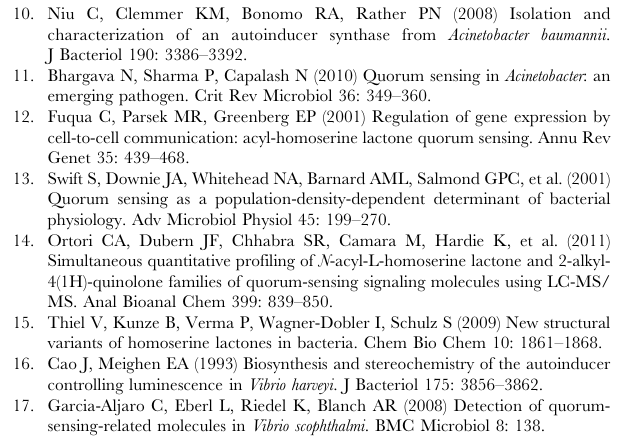
Figure S1 Conformations used for the analysis of the Mosher esters of 3b. (TIF) Figure S2 1 H NMR spectral data of 3b-( S )-MTPA ester. (TIF) Figure S3 1 H NMR spectral data of 3b-( R )-MTPA ester. (TIF) Figure S4 Preparative HPLC spectra of a mixture of 3a and 3b. (TIF) Figure S5 1 H NMR analysis. N = ( S )-Mosher acid chloride (( R )- Mosher acid); % = DMAP; e = Triethylamine; D = 3 2 [(Diethylamino)propyl]amine. (TIF) Figure S6 1 H NMR analysis. N = ( R )-Mosher acid chloride (( S )- Mosher acid); % = DMAP; e = Triethylamine; D = 3 2 [(Diethylamino)propyl]amine. (TIF) Table S1 D d ( = d S 2 d R ) data for the ( S )- and ( R )-MTPA- Mosher esters of 3b. (TIF)